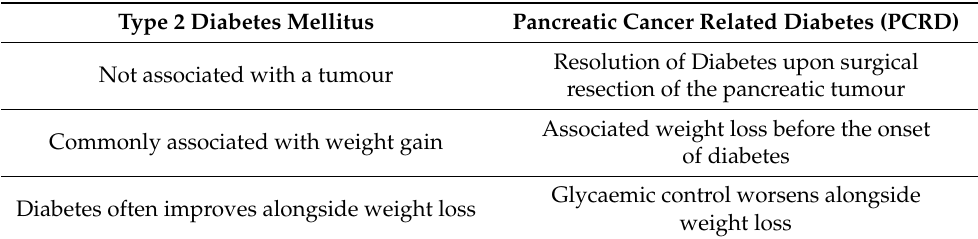
Resolution of Diabetes upon surgical resection of the pancreatic tumour Associated weight loss before the onset of diabetes Glycaemic control worsens alongside weight